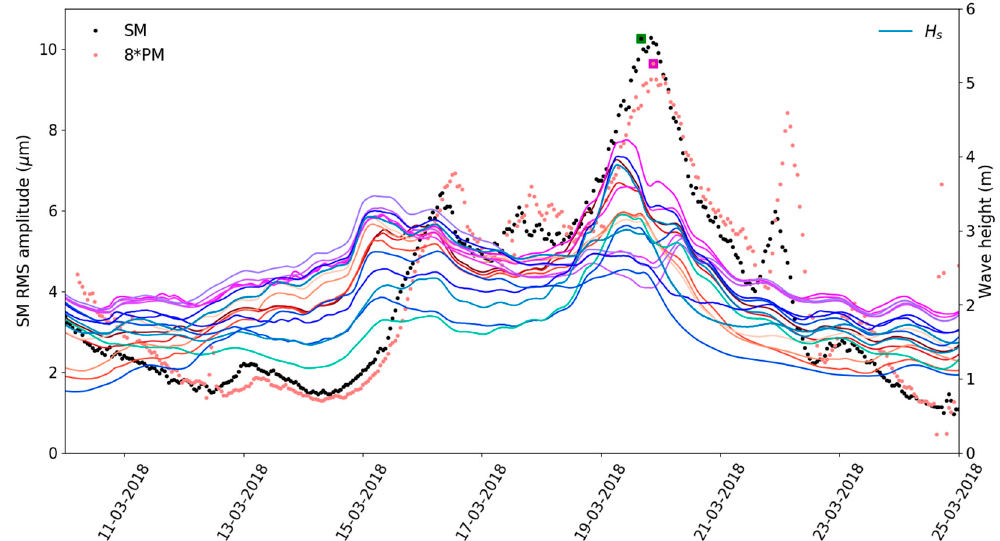
Figure 8. Seismic and swell amplitudes recorded during TS ELIAKIM in March 2018. SM (black dots) and PM (pink dots) RMS amplitude at seismic station MAT (see location Figure 6b) versus the significant wave heights ( Hs ) at different nodes around La Réunion (colored lines). Note that the amplitude of the PM is multiplied by 8 to reach about the same scale as the SM. The green and magenta dots indicate the maximum SM and PM, respectively, showing a delay of 4 h between the two. The significant waves heights Hs extracted at the various model nodes around the island (Figure 6b) are plotted in continuous colored lines with the same color codes as the stars in Figure 6b.